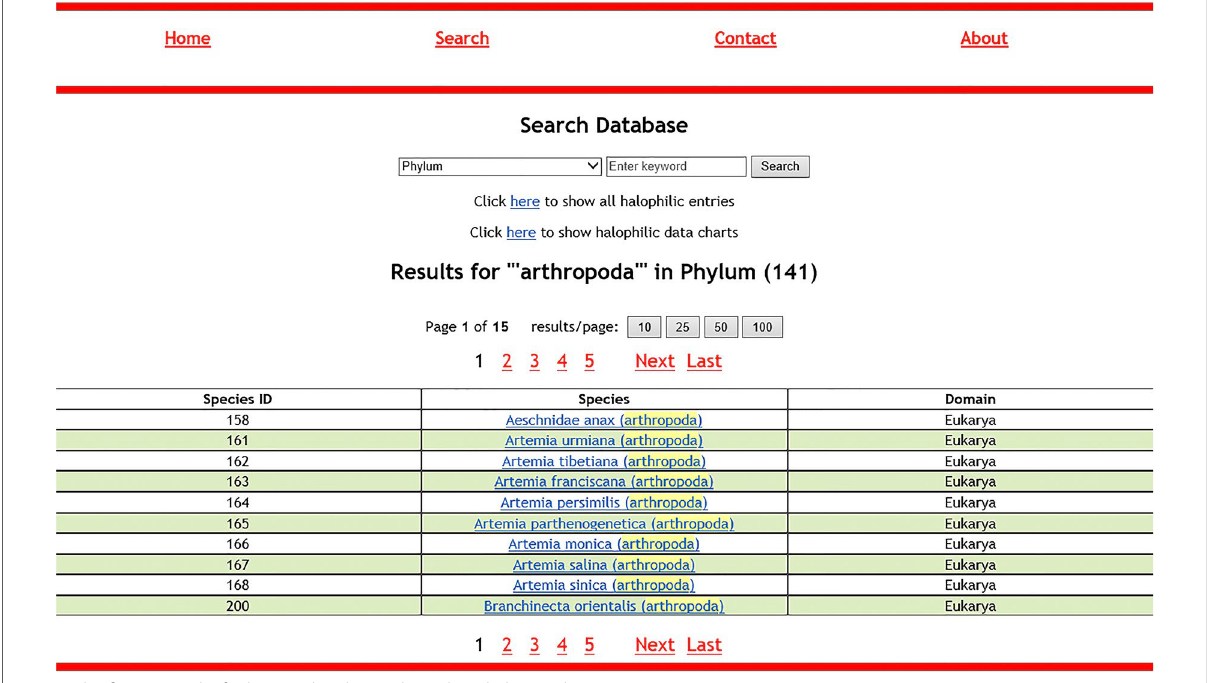
Fig. 3 The first 10 results for keyword “arthropoda” in the “Phylum” column